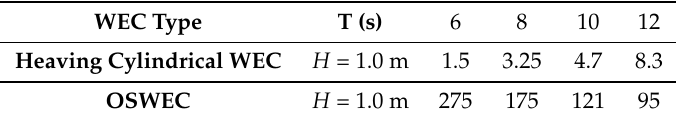
Table 3. Optimal hydraulic damping coefficients B PTO , h for a heaving cylindrical WEC (10 6 × kg/s) and OSWEC (10 6 × m 2 ·